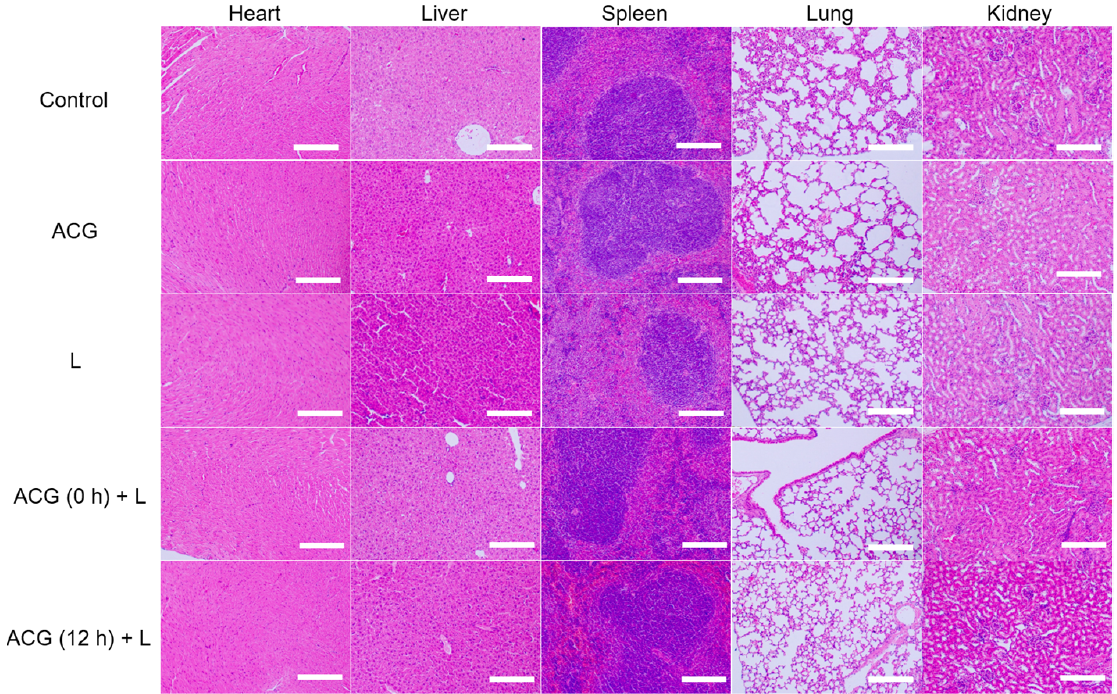
Figure 6. The representative hematoxylin and eosin (H&E) stained tissue sections of mice’s major organs, including heart, liver, spleen, lung, and kidney, after different treatments. Scale bar: 200 μ m. ACG: intratumoral injection of 50 μ L ACG hydrogel. L: 808 nm laser irradiation (2 W/cm 2 , 10 min). ACG (0 h) + L: intratumoral injection of 50 μ L ACG hydrogel followed by immediate laser irradia- tion (2 W/cm 2 , 10 min). ACG (12 h) + L: intratumoral injection of 50 μ L ACG hydrogel followed by 12 h delayed laser irradiation (2 W/cm 2 , 10 min).